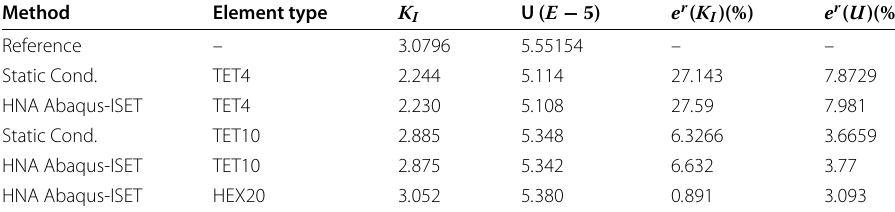
Abaqus-ISET and the non-intrusive static condensation algorithm presented in